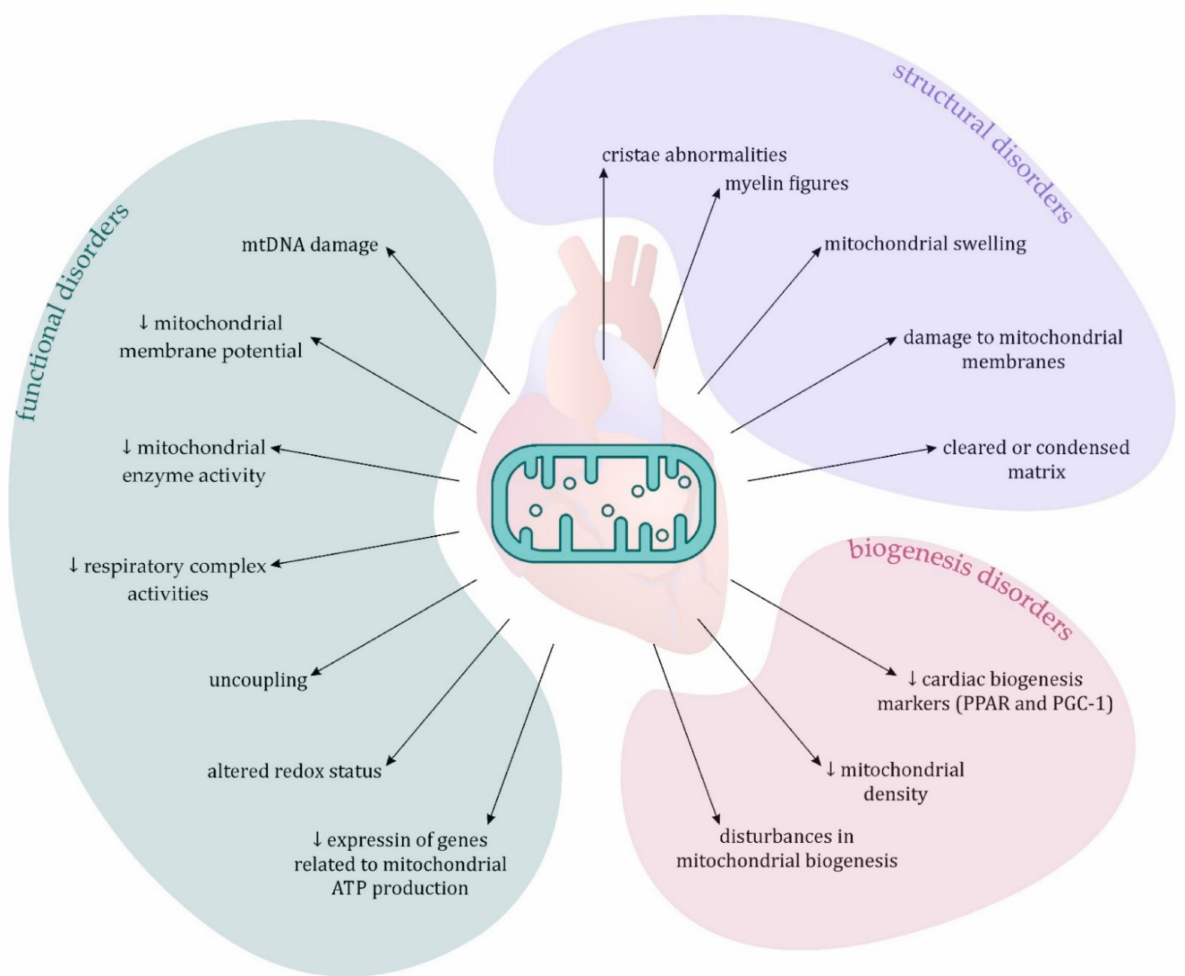
Figure 2. Changes in cardiomyocyte mitochondria in sepsis. Abbreviations: ATP = adenosine triphosphate, mtDNA = mito- chondrial deoxyribonucleic acid; PGC-1 = peroxisome proliferator-activated receptor γ coactivator 1- α , PPAR = peroxisome proliferator-activated receptor, ↓ =